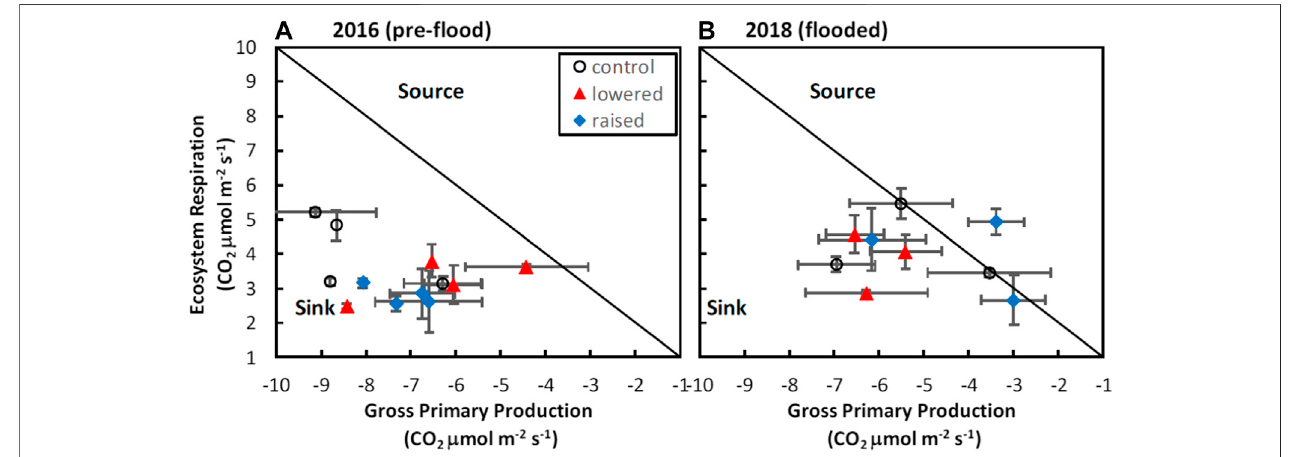
FIGURE2| Changesinecosystemcarbonbalancepriorto fl ooding,andaftertwoyearsofcontinuous fl ooding.Depictedaremeansforagivencampaignbywater table treatment plot. Error bars represent standard errors of the mean values.